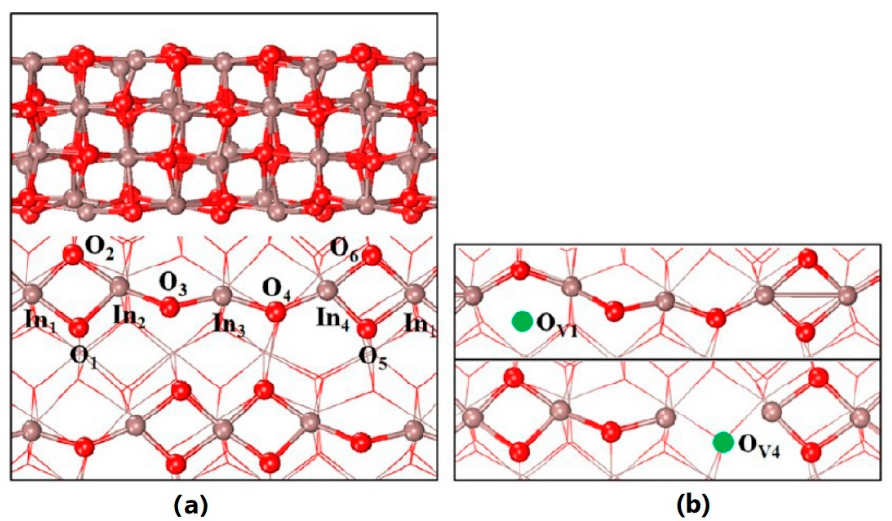
Figure 5. ( a ) Optimized structure of the In 2 O 3 (110) surface, side view (upper), and top view (lower). ( b ) The D1 ( upper ) and D4 ( lower ). Reprinted with permission from ref. [42]. Copyright 2013 ( b ) The D1 (upper) and D4 (lower). Reprinted with permission from ref. [42]. Copyright 2013 Amer- American Chemical ican Chemical Society.